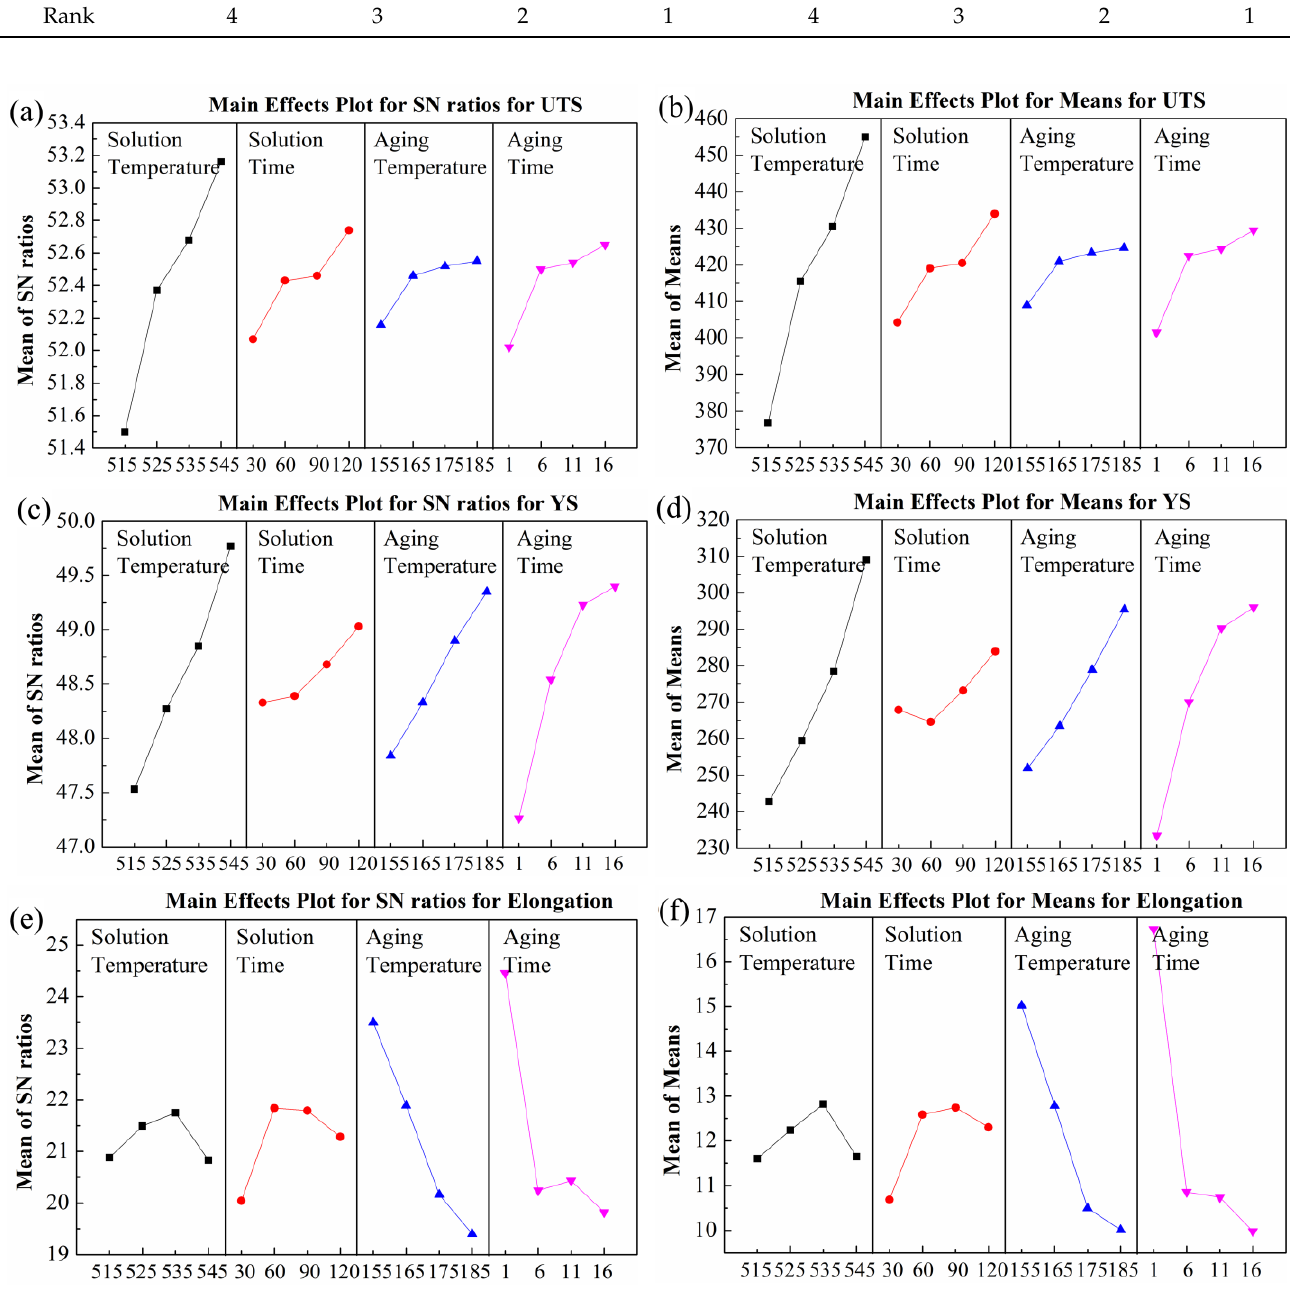
Figure 2. Main effect plots for S/N ratio and means for ( a , b ) UTS, ( c , d ) YS, and ( e , f ) elongation.